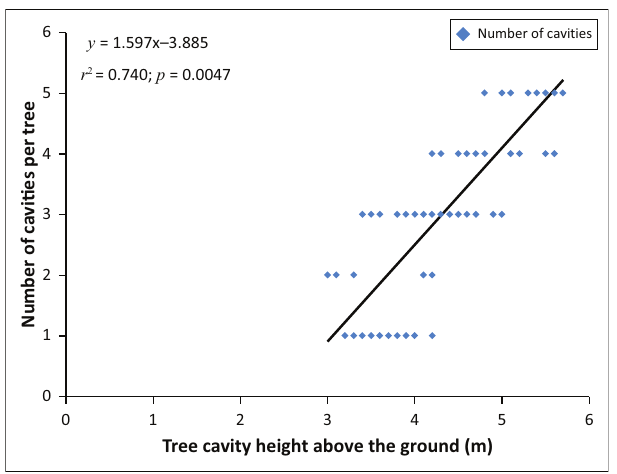
FIGURE 3: Correlates between number of cavities per standing wood and minimum tree height in the study areas of Chimfushi and Mwekera forests, Zambia, in